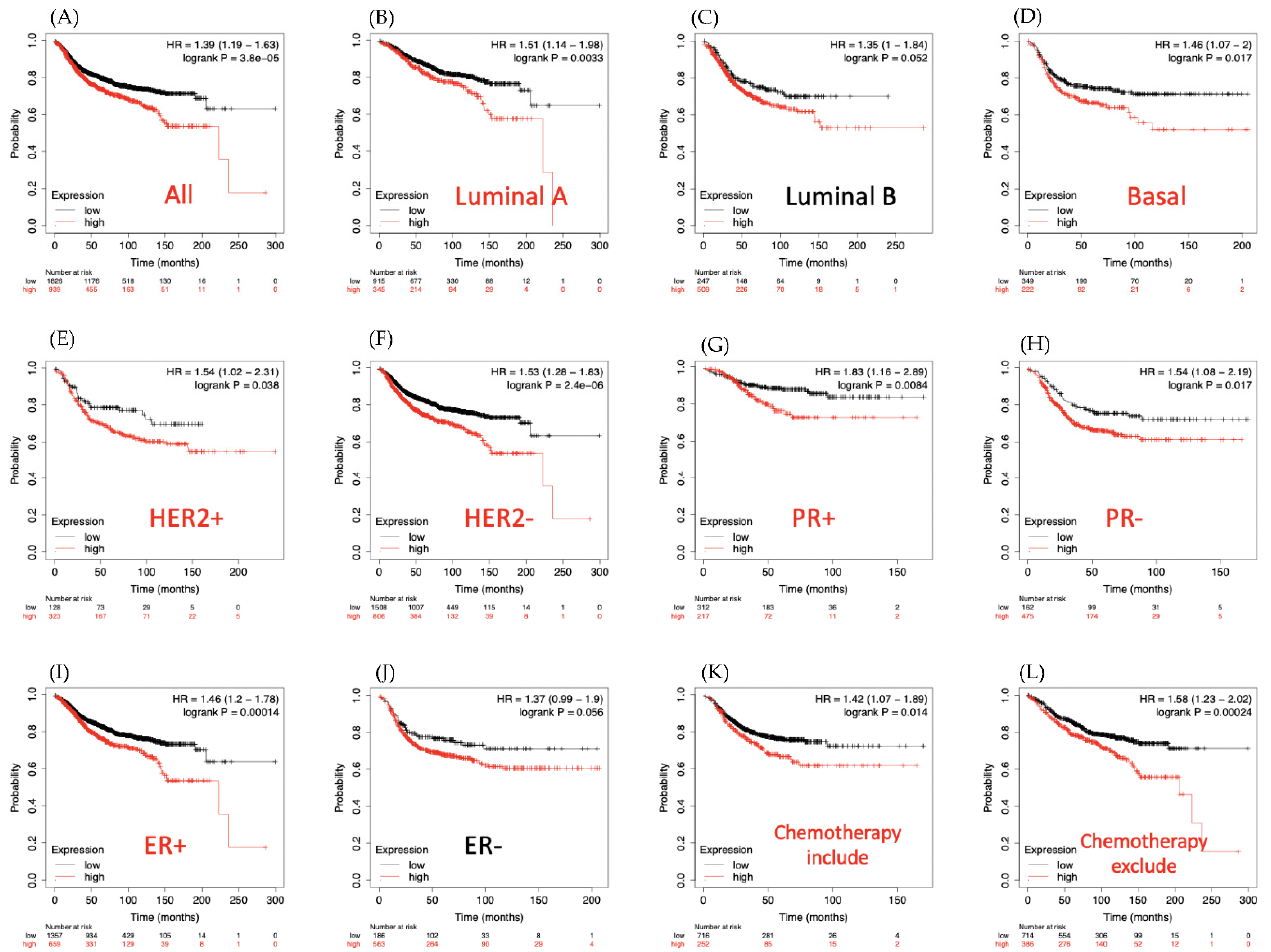
Figure 5. Survival analysis of LAGE2A expression over clinical breast cancer patients. Kaplan-Meier plots were used to indicate the distant metastasis-free survival (DMFS) prediction of breast cancer patients based on LAGE2A mRNA expression. ( A ) Overall survival, ( B ) Luminal A subtype, ( C ) Luminal B subtype, ( D ) Basal subtype, ( E ) HER2 + subtype, ( F ) HER2 − subtype, ( G ) PR + subtype, ( H ) PR − subtype, ( I ) ER + subtype, ( J ) ER − subtype, ( K ) survival analysis for